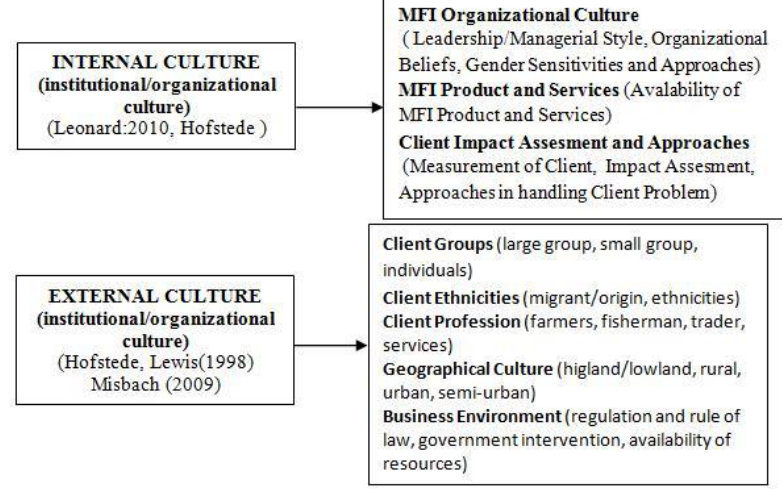
Figure 2 Local Culture